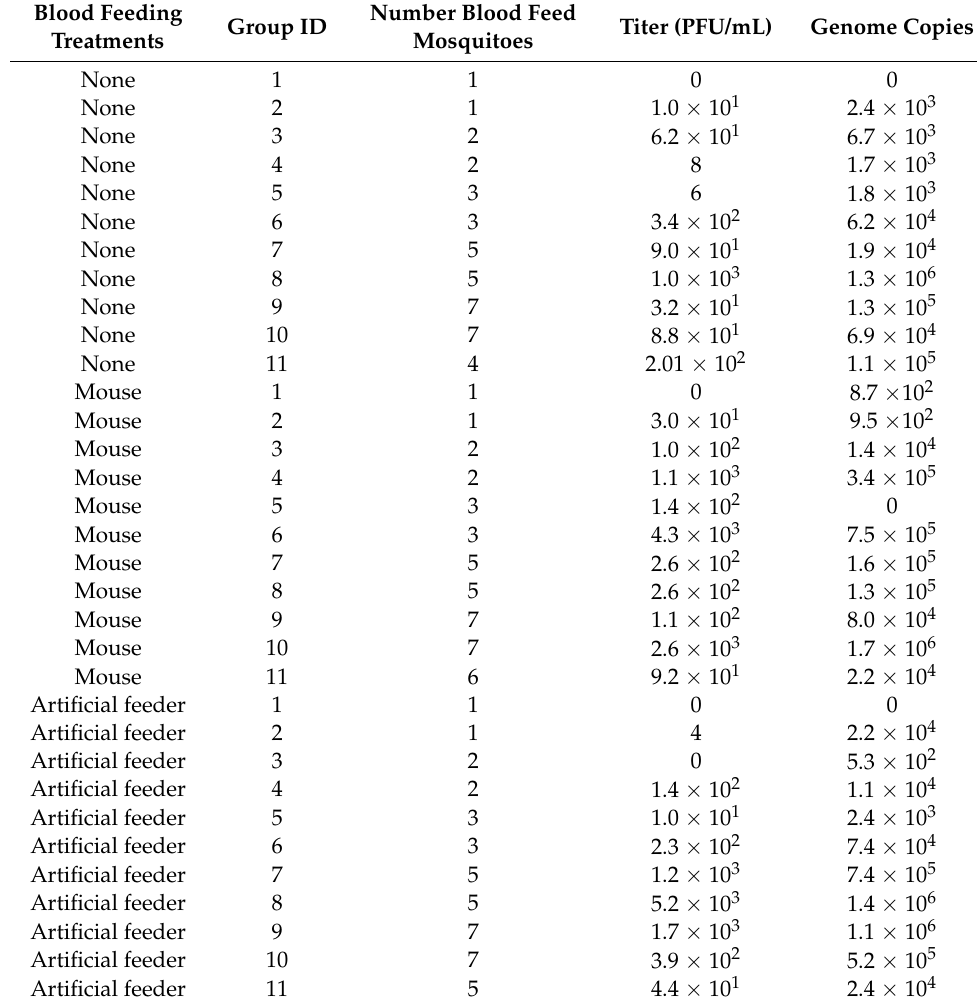
Table 3. Detection of CHIKV from forced salivation samples of groups of infected mosquitoes that underwent different blood feeding